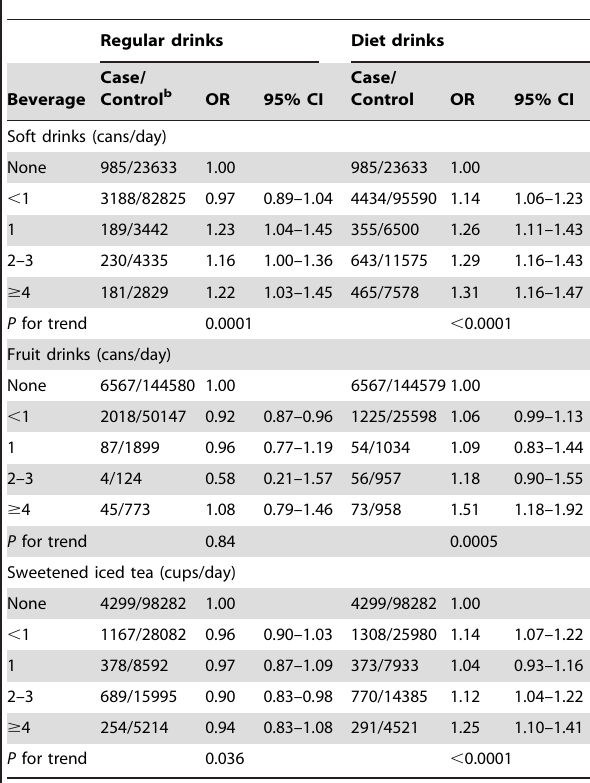
Table 3. Odds ratios a and 95% confidence intervals of depression according to baseline consumption of regular